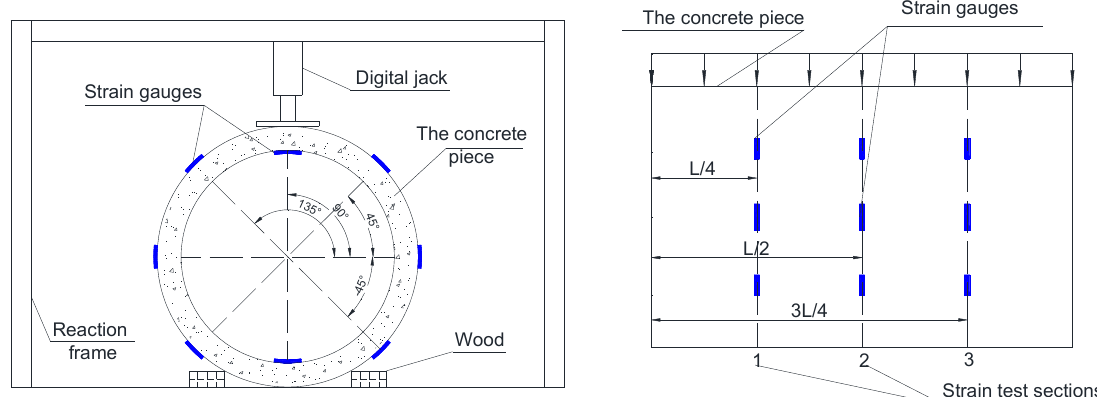
Figure 9. The test loading method.